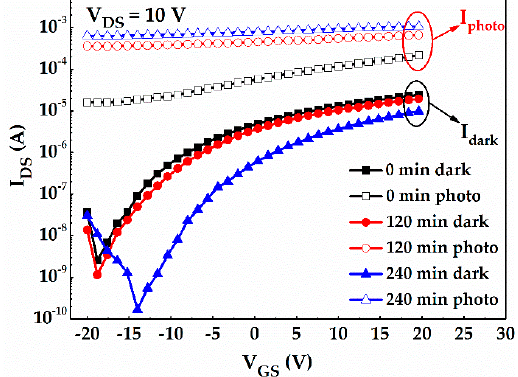
Figure 4. Output characteristics of ( a ) 0-min; ( b ) 120-min; and ( c ) 240-min annealed a-IGMO photo-TFTs.